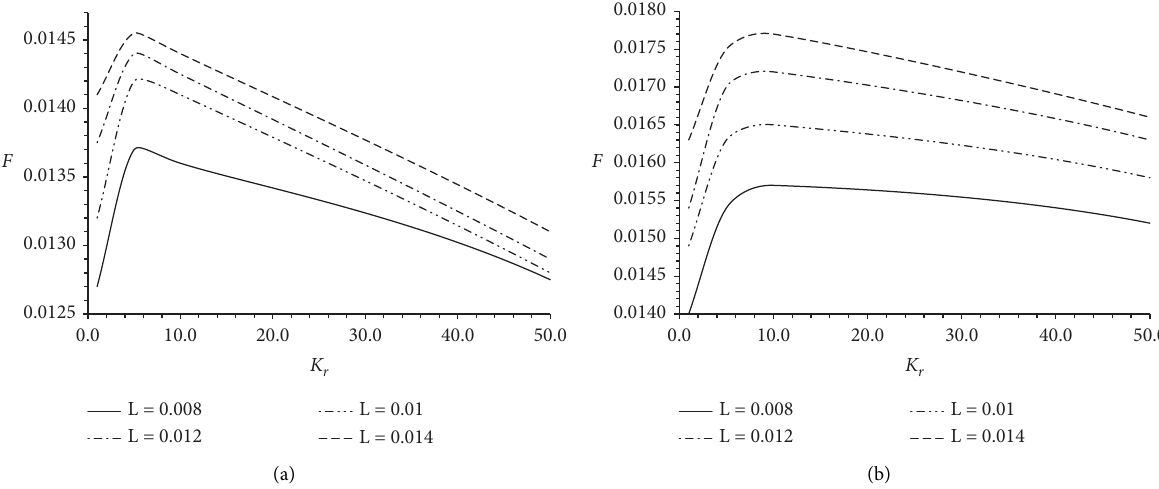
Figure 5: F vs K r at different channel heights for case O for different eccentricities, χ 2